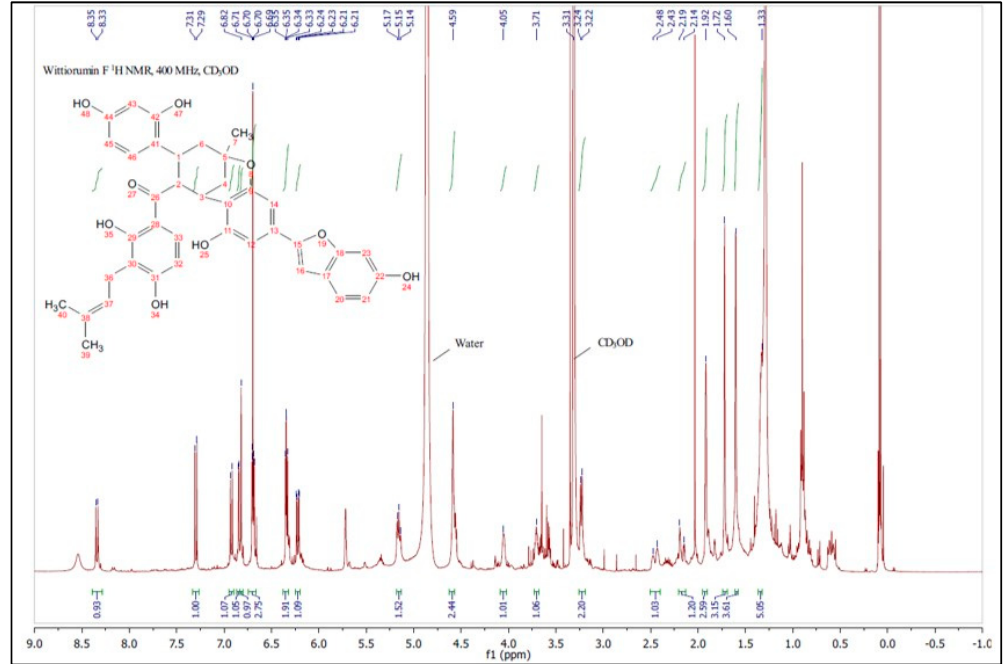
Figure A8. 1 H-NMR (400 MHz, CD 3 OD) spectrum of the compound Wittiorumin F.